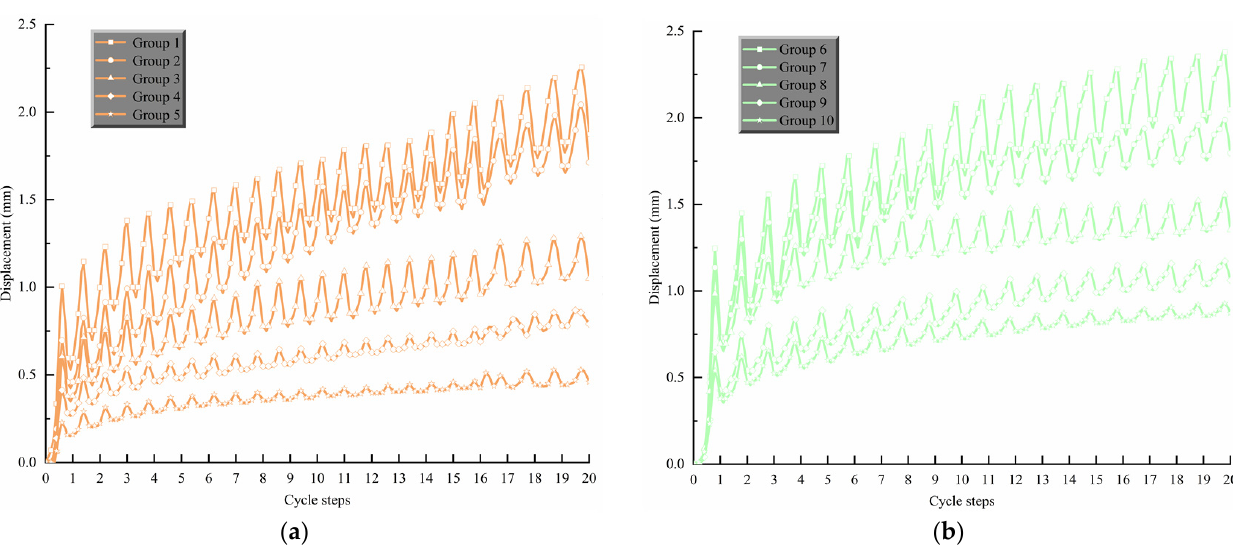
Figure 7. Curve of pile top displacement—cyclic loading steps. ( a ) H max = 3 N H min = 0 N. ( b ) H max = 4 N H min = 0 N.